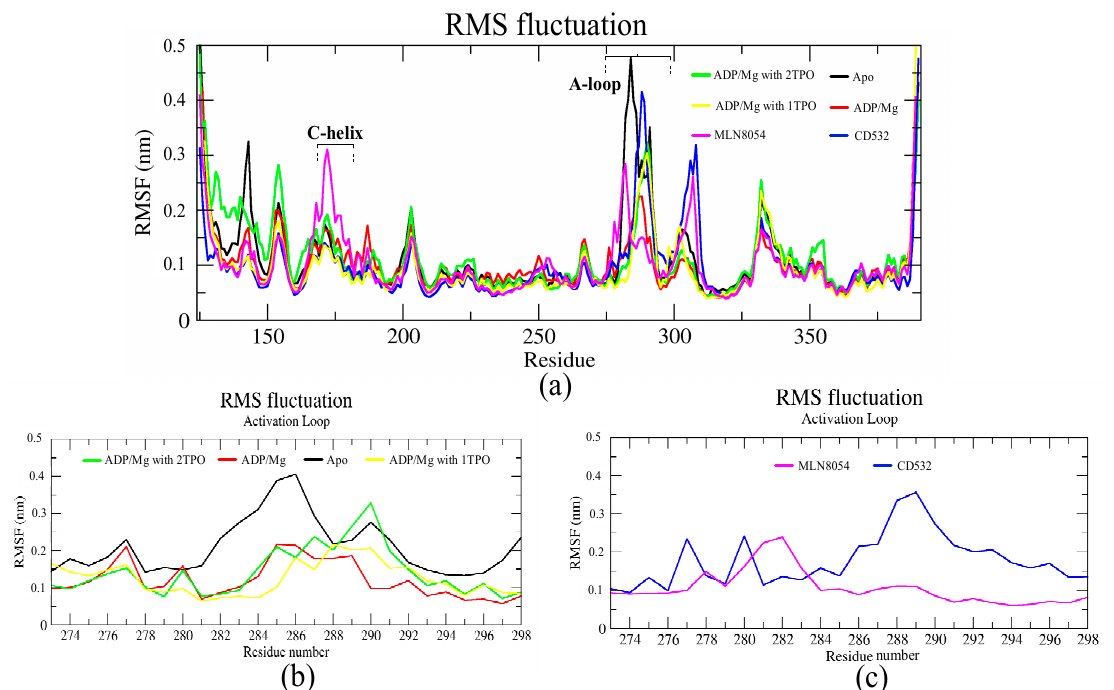
Figure 4. The RMSF plots of the Aurora-A protein for 100 ns MD. ( a ) RMSF plot of all systems including active and inactive states. ( b ) RMSF value of the A-loop in the active states: apo (4J8N, black), ADP/Mg (1MQ4, red), ADP/Mg with 2TPO (1OL7, green), ADP/Mg TPO (1OL7, yellow). ( c ) RMSF value of A-loop in the inactive states: CD532 (4J8M, blue), MLN8054 (2WTV, pink).